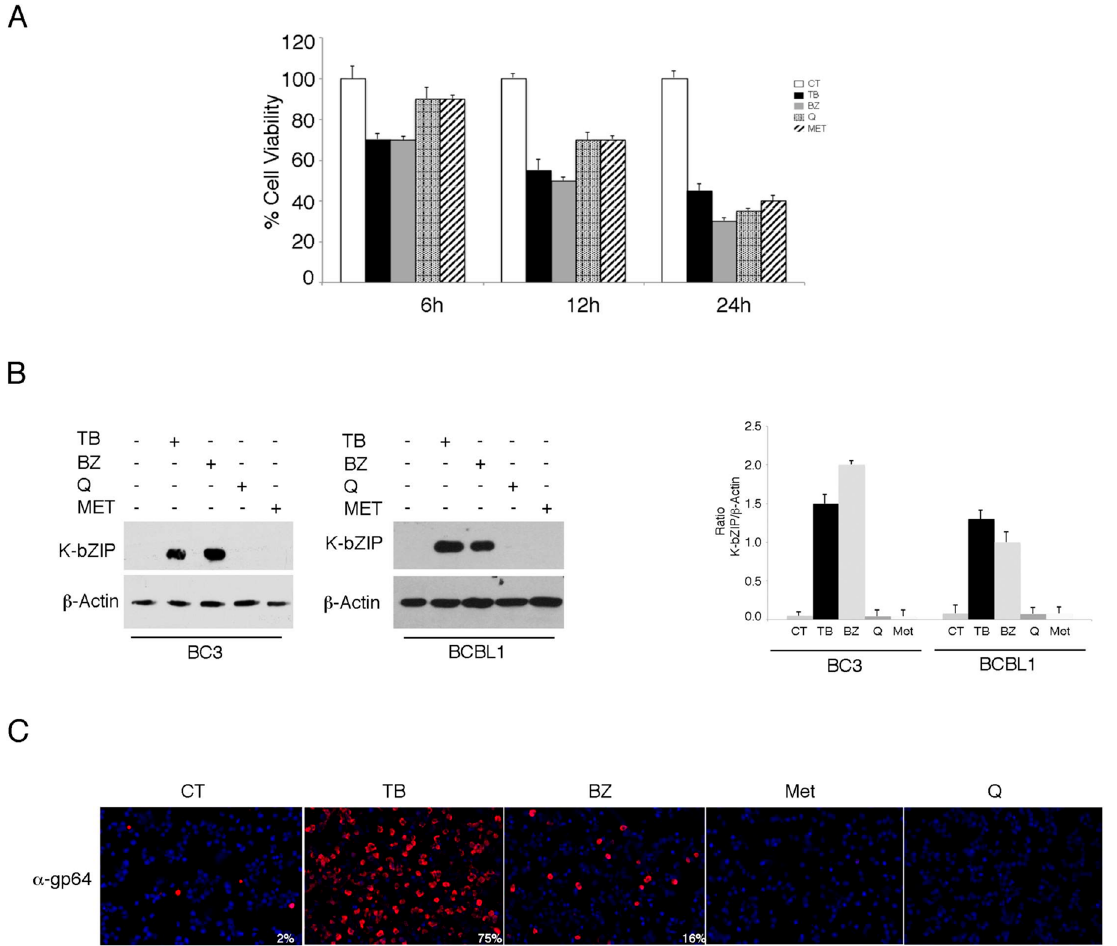
Figure 1. 12-O-tetradecanoylphorbol 13-acetate (TPA) in combination with sodium butyrate (TB) and bortezomib (BZ) induce the Kaposi sarcoma-associated herpesvirus (KSHV) lytic cycle, while metformin and quercetin fail to do so in PEL cells. ( A ) The BC3 cell line was treated with either TPA (T) (20 ng/mL) and sodium butyrate (0.3 mM) in combination (TB), bortezomib (BZ) (20 nM), metformin (MET) (20 mM), or quercetin (Q) (15 µM). Cell viability was evaluated by trypan blue